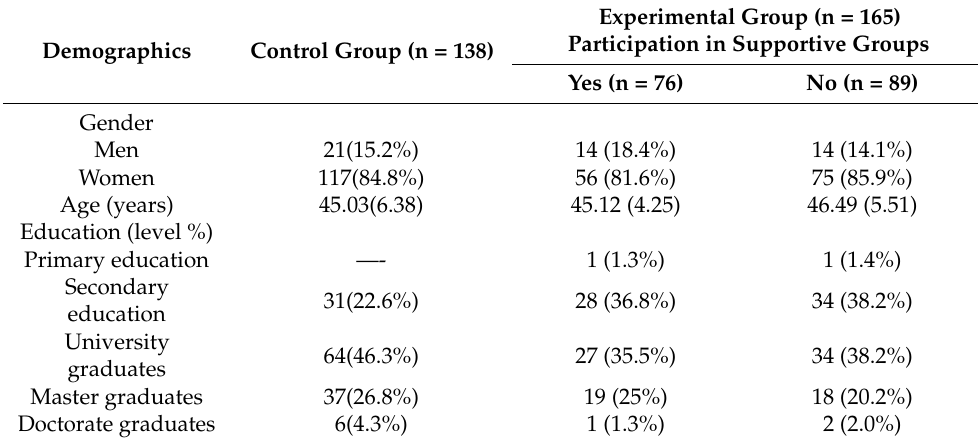
Table 1. Demographics in the control and experimental groups.